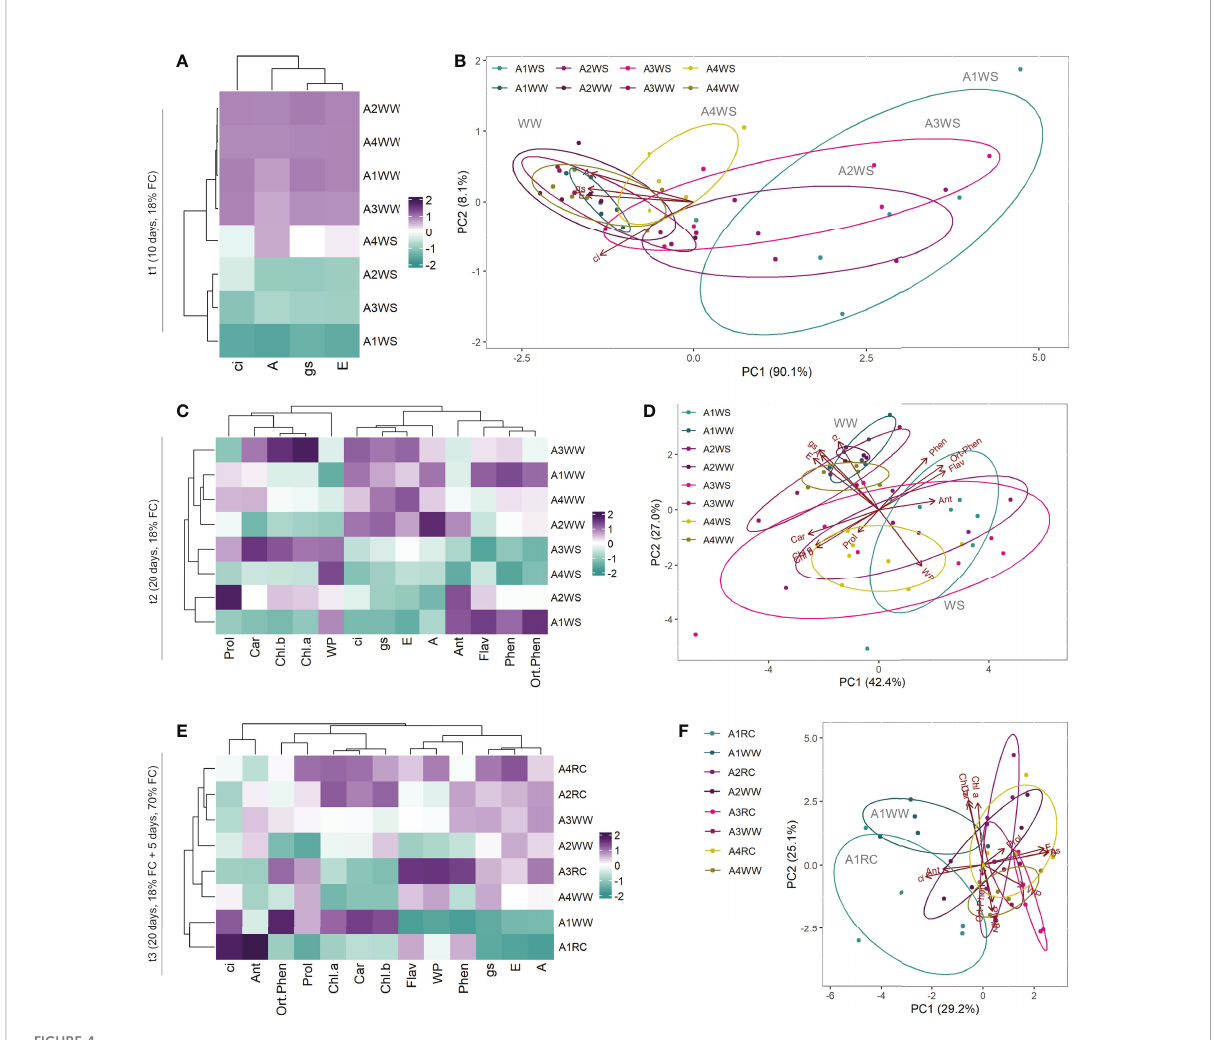
FIGURE 4 Heatmap and Principal Component Analysis with physiological and biochemical parameters measured on t1 (10 days), t2 (20 days) and t3 (20 + 5 days) on 4 genotypes (A1, A2, A3 and A4) and 3 water regimes (well-watered, water-stress and recover): heatmap on t1 (A) , PCA on t1 (B) , heatmap on t2 (C) , PCA on t2 (D) , heatmap on t3 (E) and PCA on t3 (F) . A, net CO 2 assimilation rate; Ant, anthocyanins; Car, carotenoids; Chl.a, chlorophyll a; Chl.b, chlorophyll b; ci, intercellular CO 2 concentration; E, transpiration rate; Flav, fl avonoids; gs, stomatal conductance; Phen, phenols; Prol, proline; Ortho.Phen, ortho-phenols; WP, water